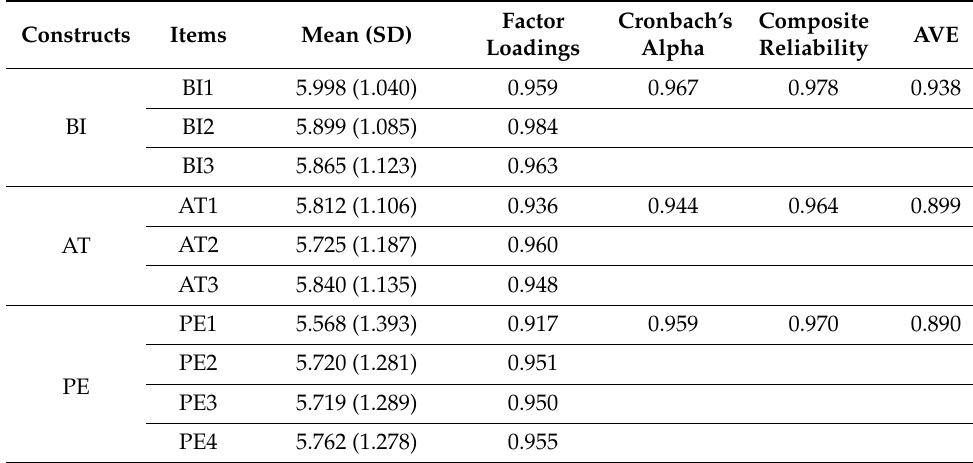
Table 2. Testing results for convergent validity and internal